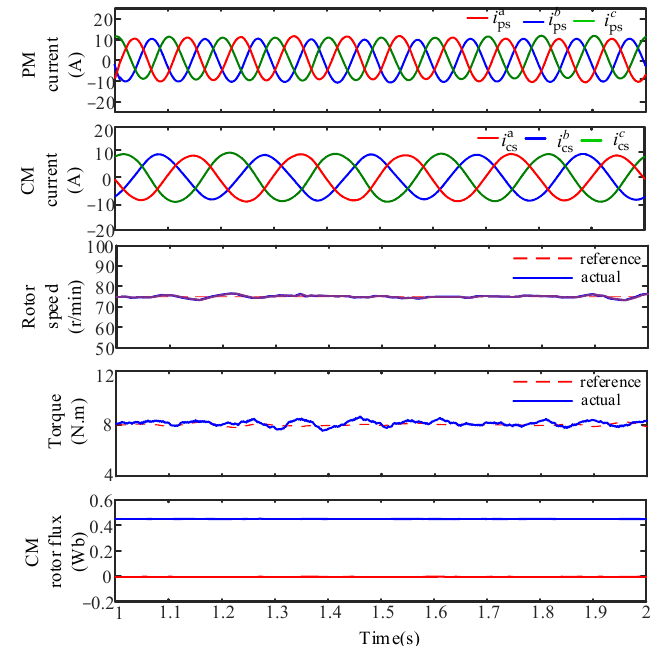
Figure 18. Experimental results at a synchronous speed of 150 r/min.